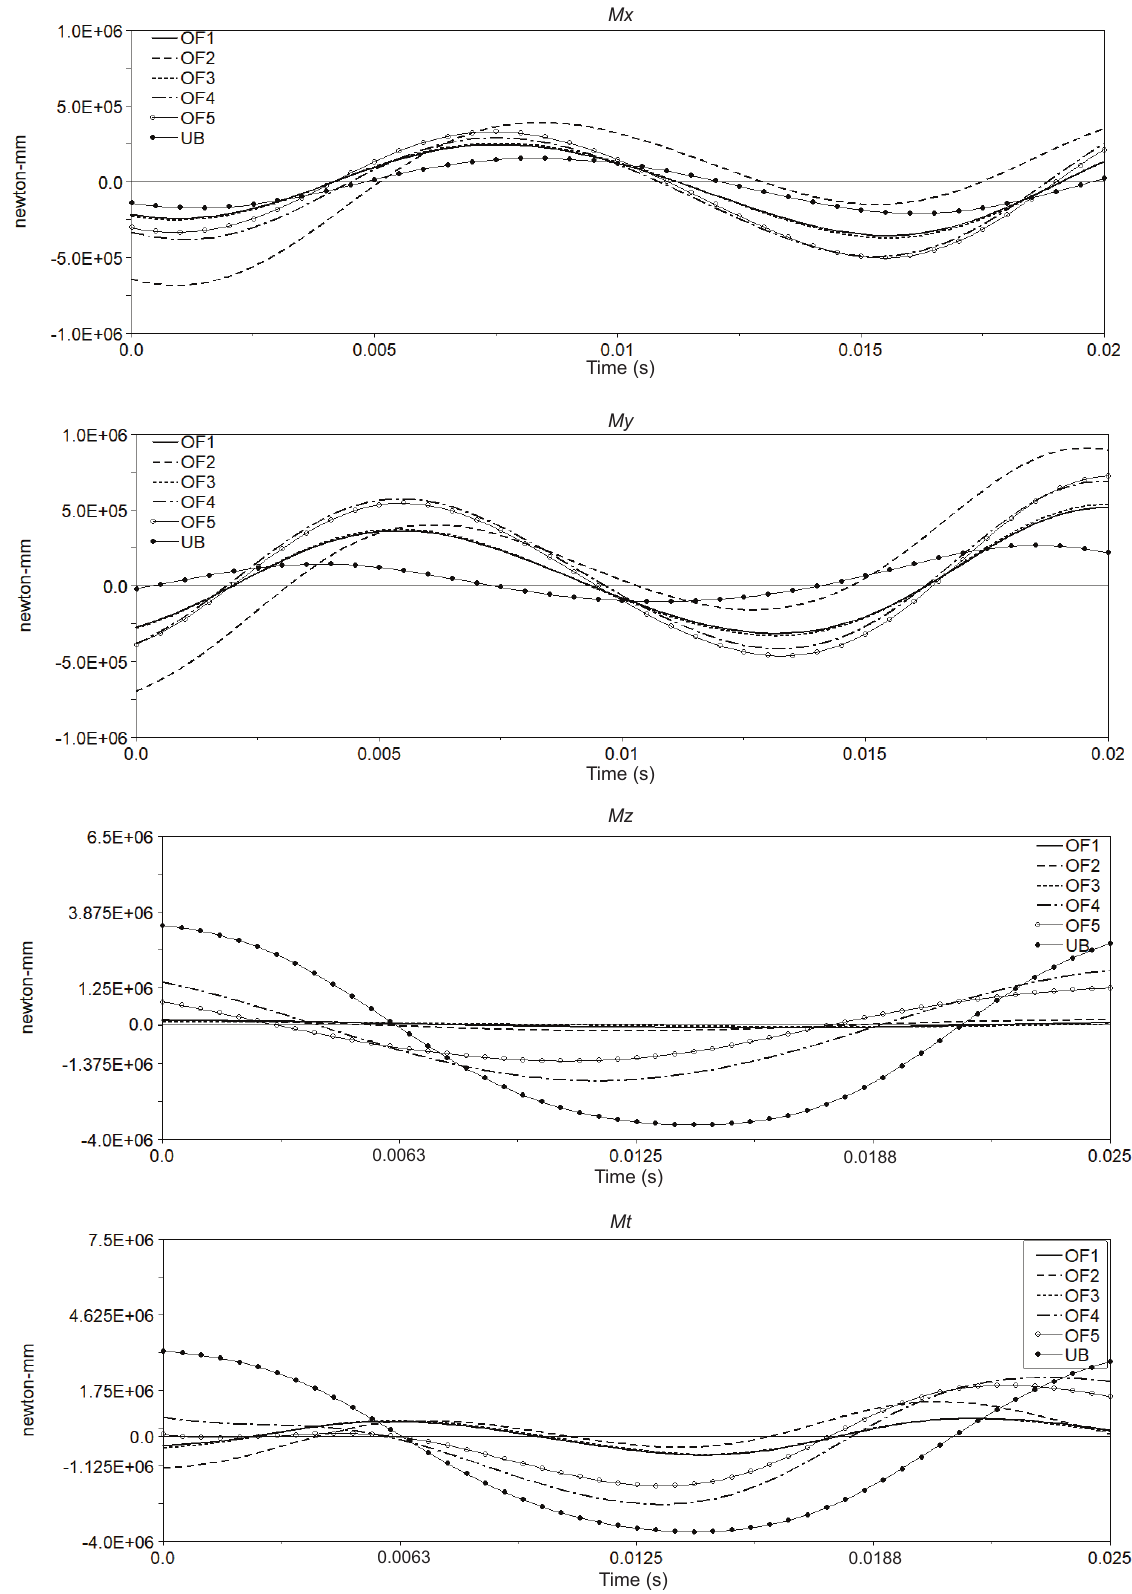
Fig. 5. Unbalanced (UB) and balanced shaking moment components for the suggested